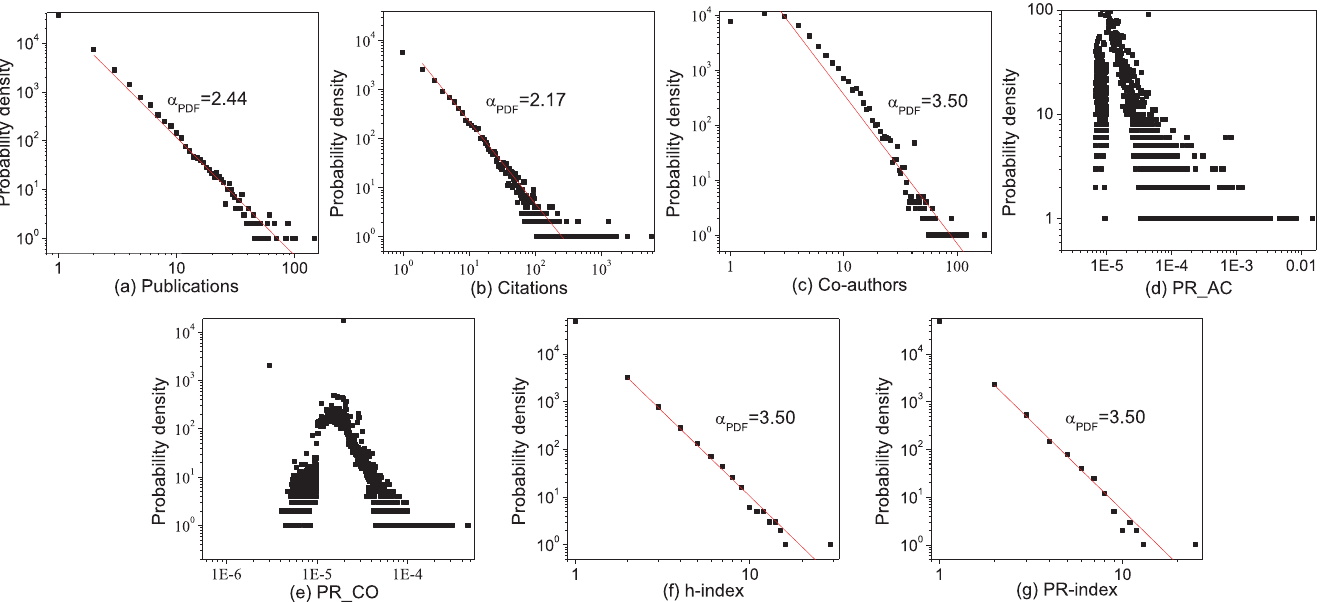
Fig 2. The distribution of different indicators with logarithmic scales. The x-axes denote different indicators, i.e., the total number (a) publications and (b) citations, the total number of (c) cooperations with others, the values of (d) PR_AC and (e) PR_Co based on the author citation network and co- authorship network respectively, and the values of (f) h -index and (g) PR-index. From this figure, some indicators (i.e., Publications, Citations, Co-authors, h -index and PR-index) approximately follow a power law distribution. The power-law exponents are estimated with the maximum likelihood estimation based on the Matlab toolkit provided by Newman [23]. While, the log-log plots of PageRank as shown in (d, e) do not follow a power-law